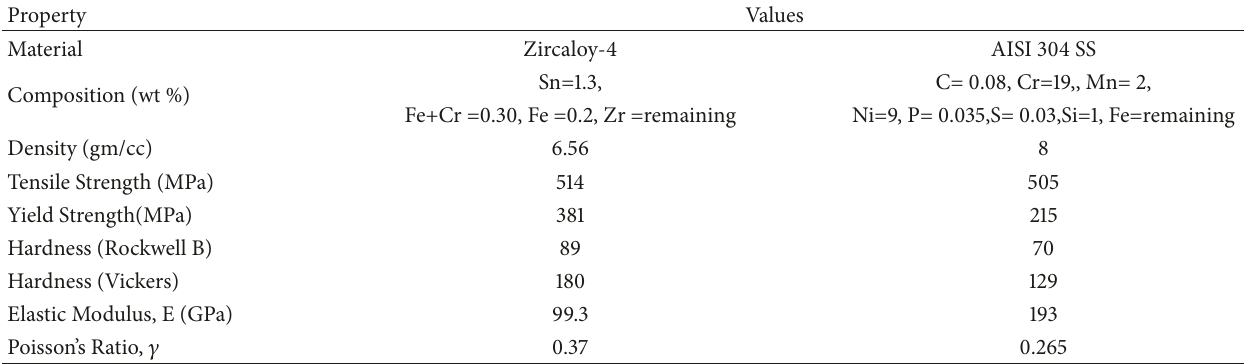
Table 1: Properties of zircaloy-4 and AISI 304 SS [9].